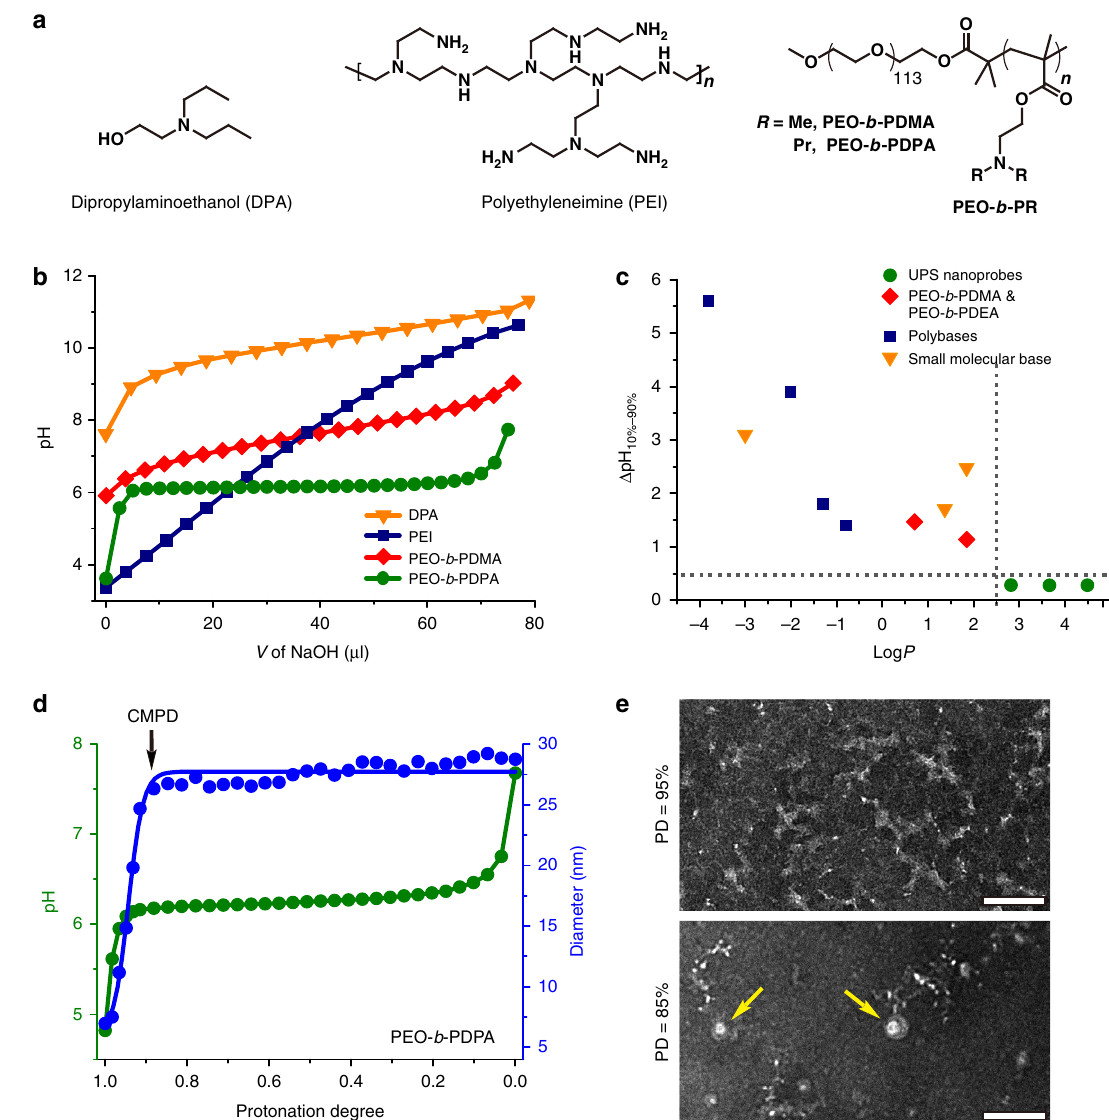
Figure 2 | Hydrophobic phase separation drives sharp pH response of UPS copolymers. ( a ) Structures of small molecular base dipropylaminoethanol (DPA), polymeric bases of PEI, PEO- b -PDMA and PEO- b -PDPA. ( b ) pH titration curves of DPA, PEI, PEO- b -PDMA and PEO- b -PDPA. ( c ) Plot of pH transition sharpness ( D pH 10–90% ) as a function of octanol–water partition coefficient (Log P ) of small molecular bases (NH 4 Cl, Chloroquine and DPA) or repeating unit (neutral monomer) of commonly used polybases (poly(ethyleneimine), polylysine, chitosan, polyhistidine) and PEO- b -PR block copolymers. ( d ) Change of hydrodynamic diameter of UPS nanoprobe PEO- b -PDPA along pH titration coordinate. Significant increase of size indicated the formation of micelles. ( e ) TEM images of PEO- b -PDPA before (protonation degree at 95%) and after (protonation degree at 85%) critical micelle protonation degree (CMPD ¼ 90%). Micelle formation (yellow arrows) was observed when protonation degree was below CMPD. Scale bars, 100 nm. NATURE COMMUNICATIONS|7:13214|DOI: